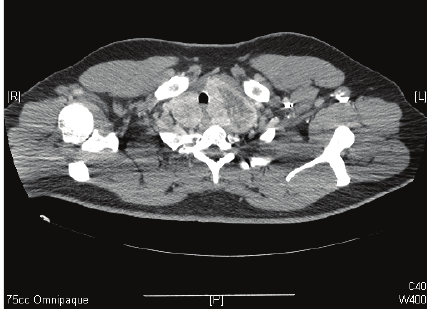
Figure3:AxialCTscanatT5revealingthepresenceofanincidental right-sided thoracic